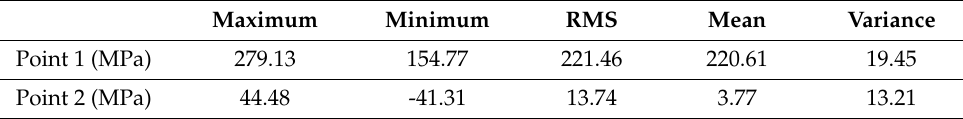
Table 3. The statistics of the maximum principal stress on test points 1 and 2.